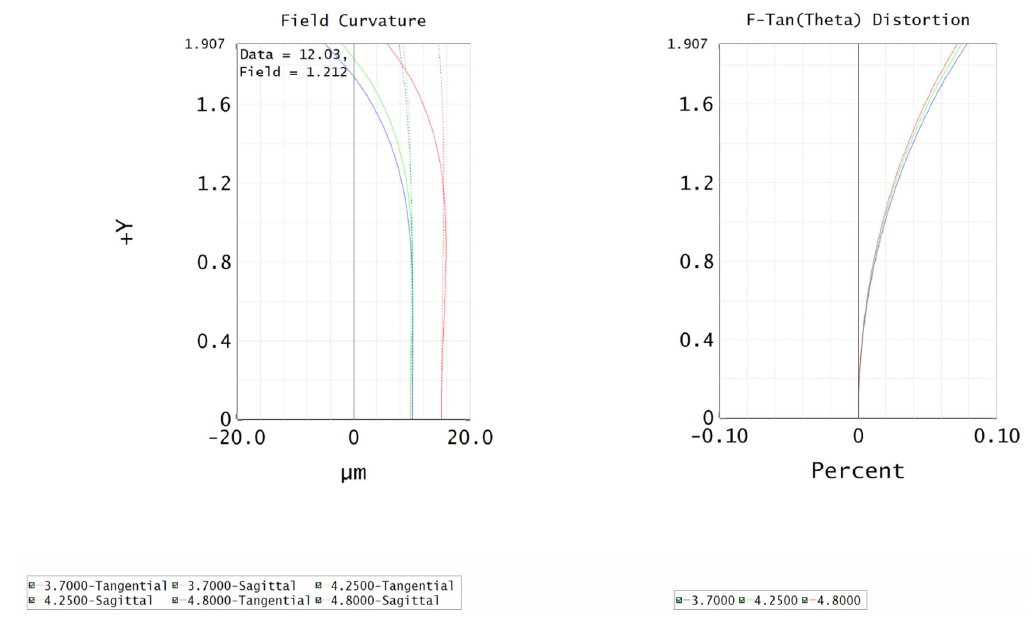
Figure 15. Aberration curve of infrared lens at 20 °C.